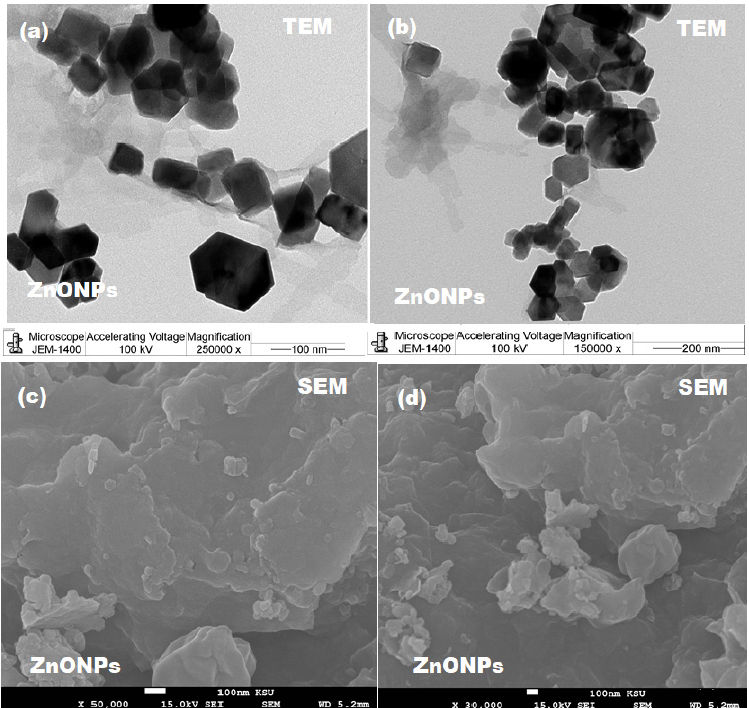
Figure 3. ( a , b ) TEM images at ×250,000 and ×150,000 magnification and ( c , d ) SEM images at ×50,000 and ×30,000 magnification of ZnONPs.